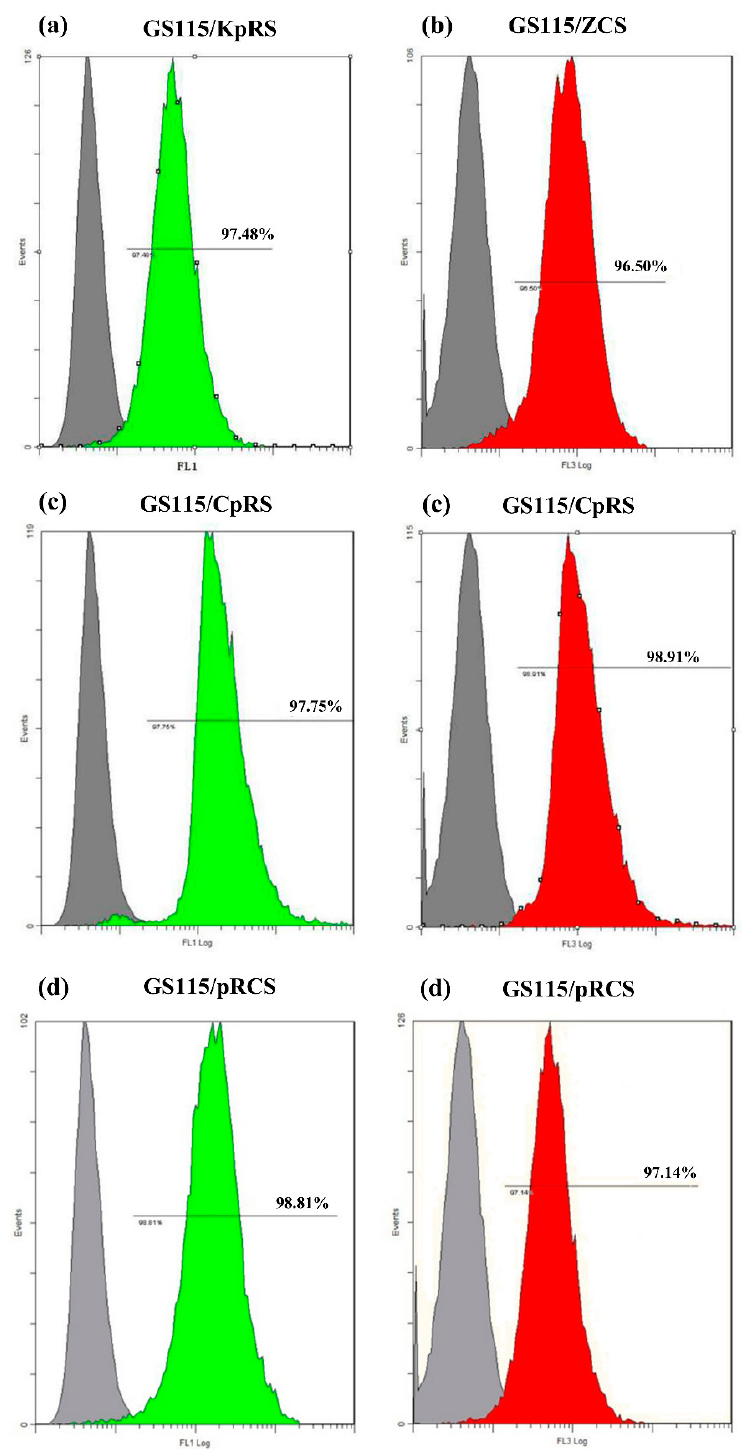
Figure 2. Determination of expression levels of single-displayed Rhizopus oryzae lipase (ROL) and Candida rugosa lipase 1 (CRL1) and codisplayed ROL plus CRL1 proteins on the Pichia pastoris GS115 surfaces and comparison with those on the control GS115 cells through FACS. ( a ) The ROL display rate was ~97.48% for the GS115/KpRS recombinants based on the green fluorescence peaks. ( b ) The CRL1 display rate was ~96.50% for the GS115/ZCS recombinants based on the red fluorescence peaks. ( c ) The ROL and CRL1 expression rates were 97.75% and 98.91%, respectively, on the P. pastoris GS115/CpRS surfaces. ( d ) The ROL and CRL1 expression rates were 98.81% and 97.14%, respectively, on the P. pastoris GS115/pRCS surfaces. The gray histogram represents the negative control.